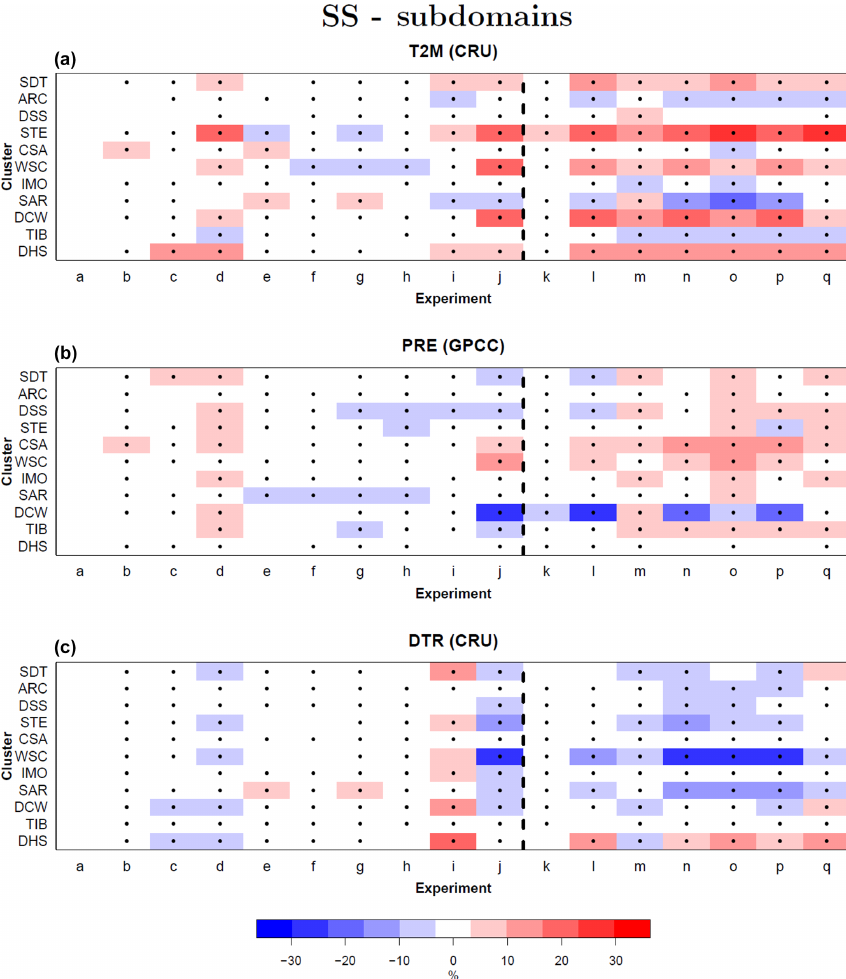
Figure 8. Skill score (SS) derived from the MAE calculated for each domain subregion over the monthly climatological values of the seasonal cycle of different COSMO-CLM simulations and observational data sets. From top to bottom, each panel represents the results obtained for near-surface temperature (T2M) using the CRU, for precipitation (PRE) using the GPCC and for diurnal temperature range (DTR) using the CRU as observational data sets. Positive (negative) values indicate better (worse) performance of the considered simulations compared to the reference one. The points in correspondence of different clusters and experiments indicate that the change is the SS is the same in sign among the three observational data sets considered for each